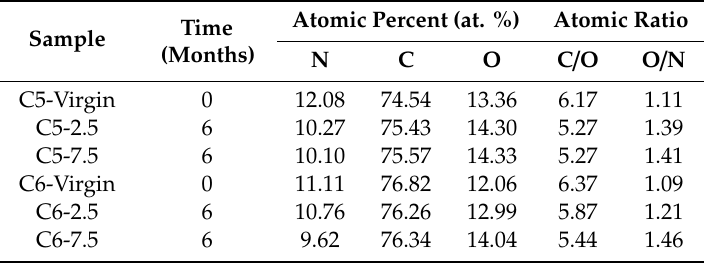
Table 4. The surface elemental composition of the RO membranes prior and after 6 months to exposure to the acid solutions by XPS.